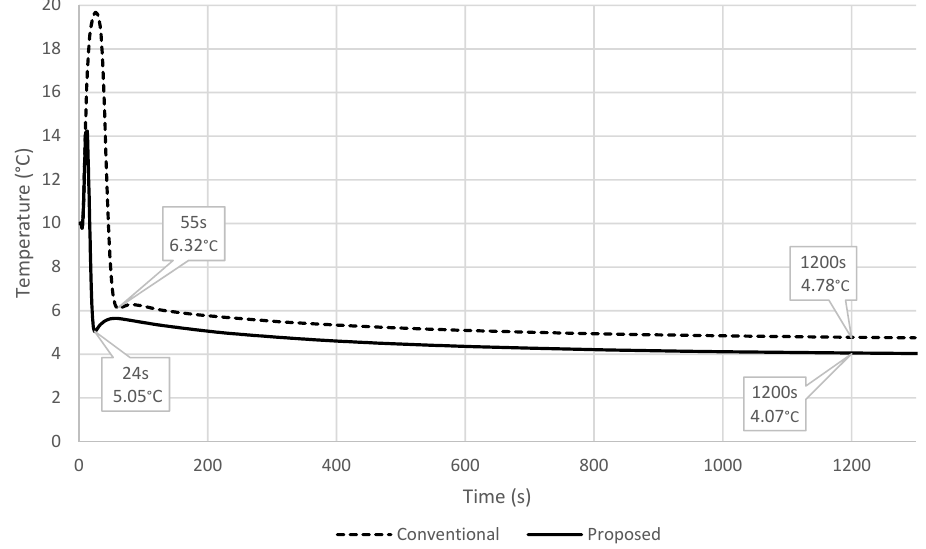
Figure 11. Average intake air temperature at the middle plane as a function of operating time.